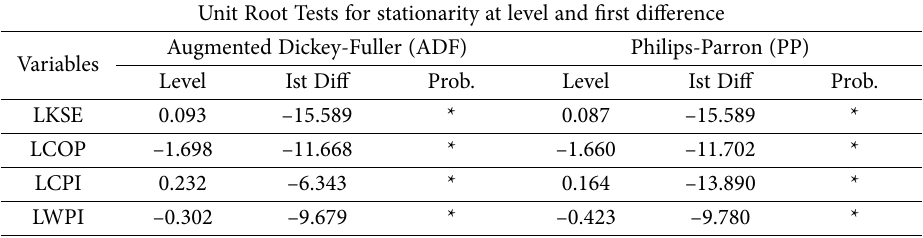
Table 1. Stationarity tests result (Philips-Parron & Augmented